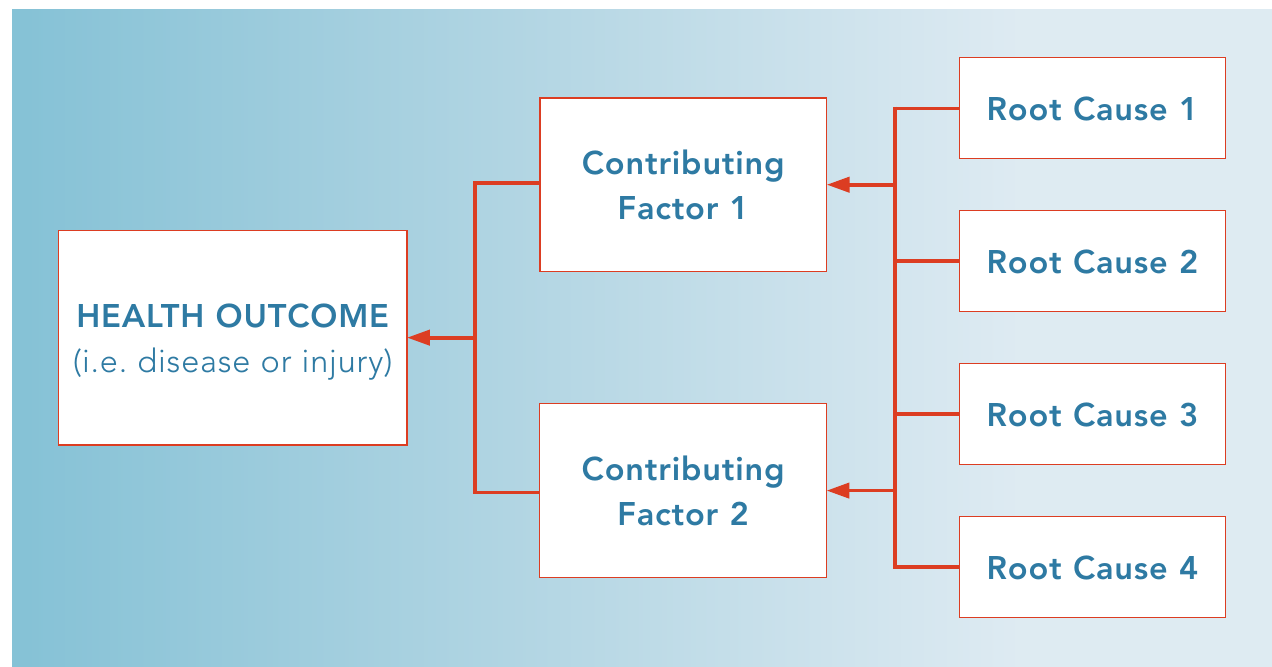
FIGURE 3. SIMPLE ROOT CAUSE